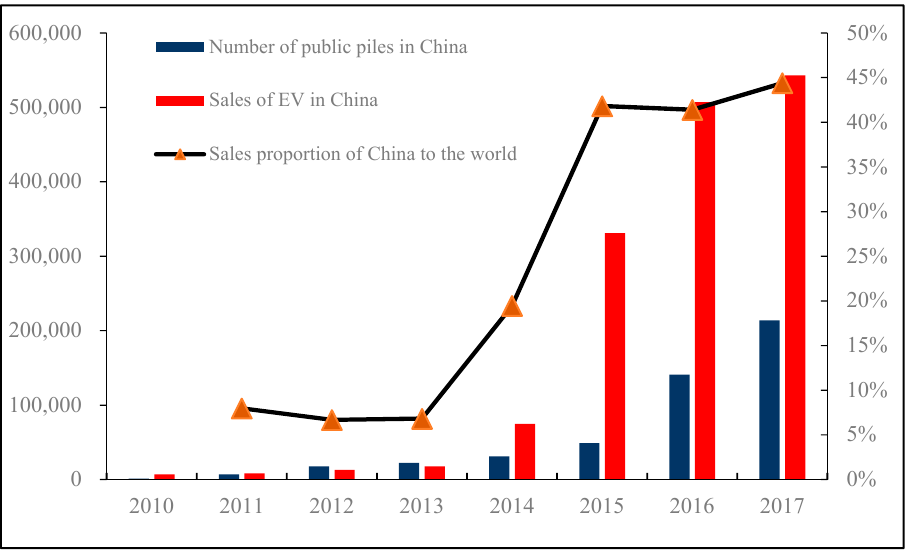
Figure 1. The number of electric vehicles (EVs) and public charging infrastructure in China.